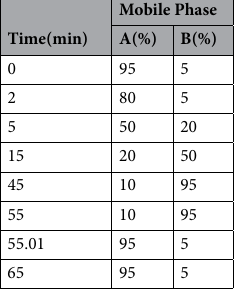
Table 5. LC/MS-Q-TOF gradient elution program.